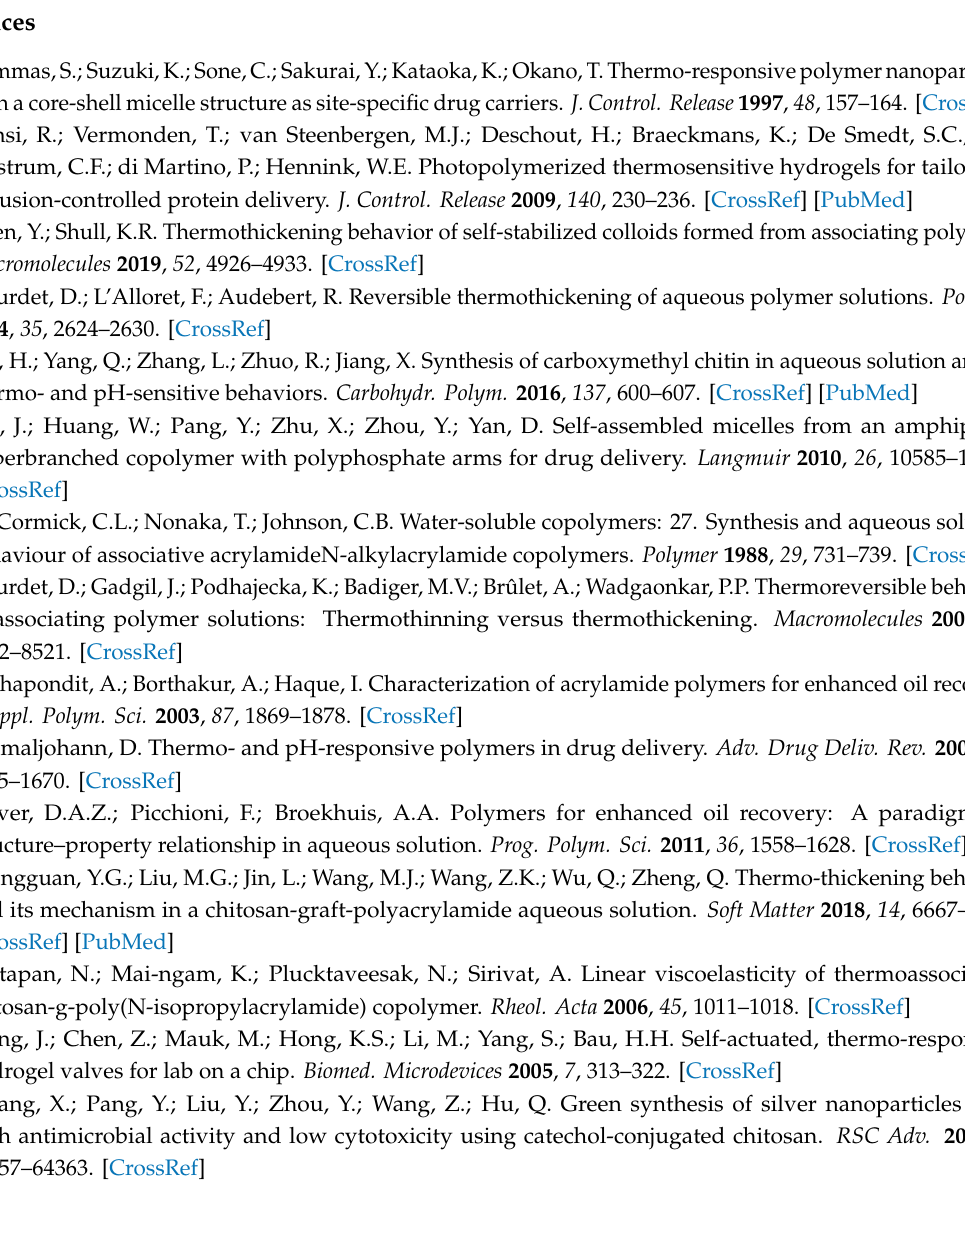
Figure S1: 1 H-NMR spectrums of 0.5 wt.% CS solution in an acetic acid-d 4 / water-d 2 mixture at room temperature (the DDA value of samples of (a) and (b) are 79% and 98% respectively). Figure S2: 1 H-NMR spectrums of CS and GPAM in an acetic acid-d4 / water-d2 mixture at room temperature. Figure S3: Relationship between the degree of protonation of the amino group and the concentration. Table S1: Molecular parameters of